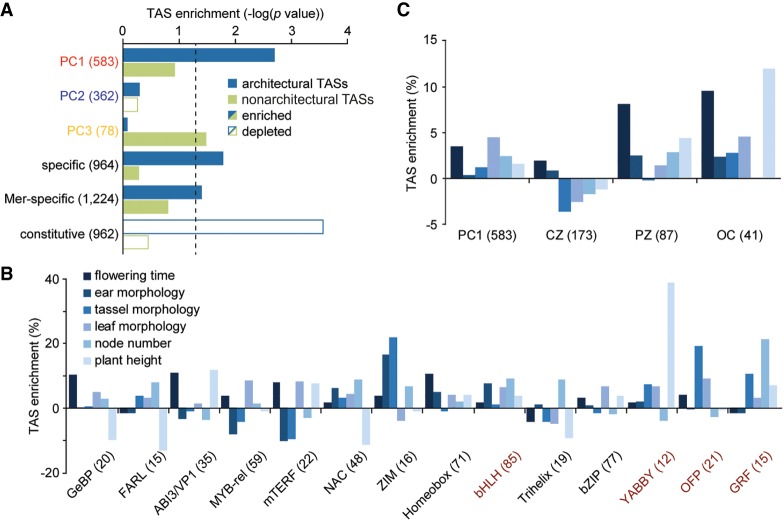
Dynamically expressed meristem genes modulate architectural traits. (A) Significance plot illustrating that natural variation underlying plant architectural traits is significantly enriched specifically near PC1-correlated TFs, dynamically expressed genes, and meristem-specific genes. In contrast, architectural TASs are strongly depleted near constitutively expressed genes. Dashed line, significance threshold (P = 0.05) based on χ2 test with Yates’ continuity correction. Input gene numbers are given in parentheses. (Mer) Meristem. (B) Enrichments of TASs near individual TF families either positively (black) or negatively correlated (red) to PC1 shows different TF families shaping distinct morphological features. (C) Enrichments of TASs influencing individual architectural traits near PC1-correlated TFs and genes marking the PZ and OC. TASs for most architectural traits are depleted near CZ-specific genes.